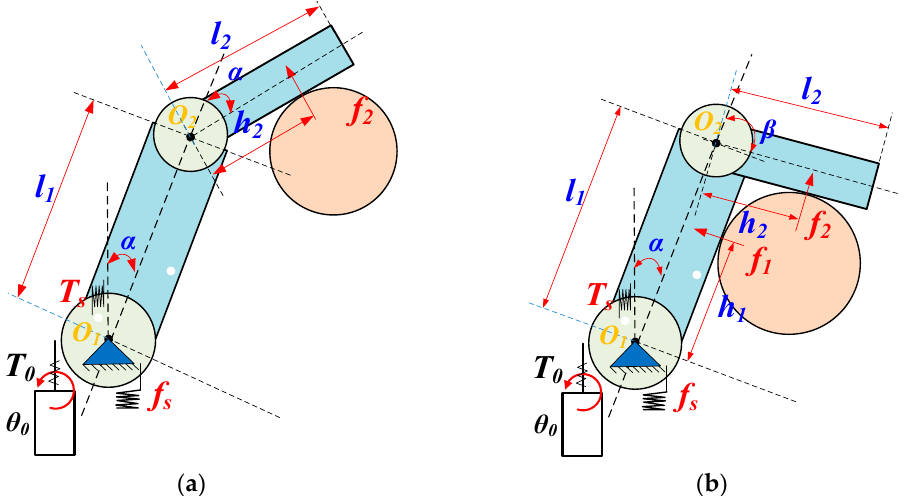
Figure 10. Mechanical analysis of the ESMGM hand (COSA mode): ( a ) Coupled grasping; ( b ) self- adaptive grasping.